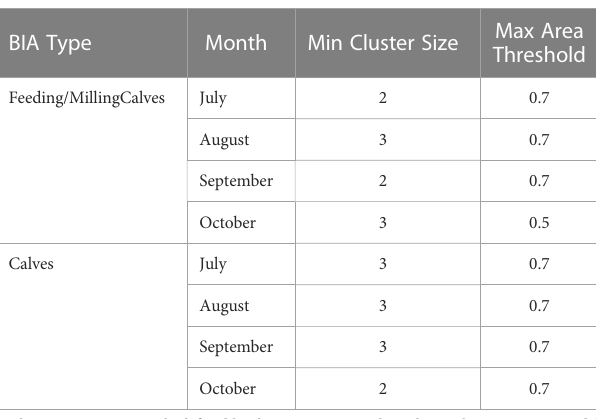
TABLE 2 Spatial optimization model scenarios selected for the analysis of inter-annual variability in bowhead whale feeding/milling and calf Biologically Important Areas